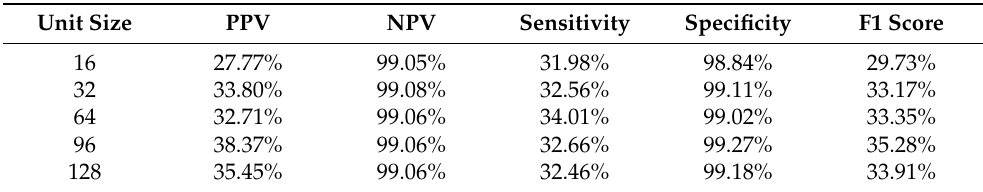
Table 5. Performance evaluation of LSTM model. We evaluated the performance according to LSTM layer unit size. The highest PPV was 96 and highest NPV was 32. The highest sensitivity was 64 and highest specificity was 96. The highest F1 score was 96.